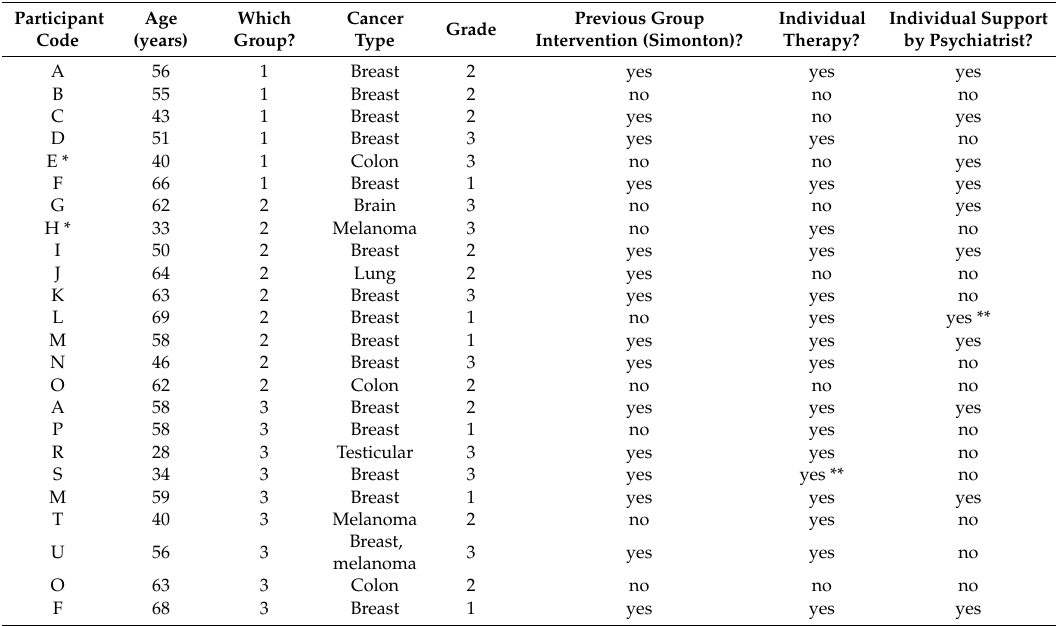
Table 3. Summary of participant data for all